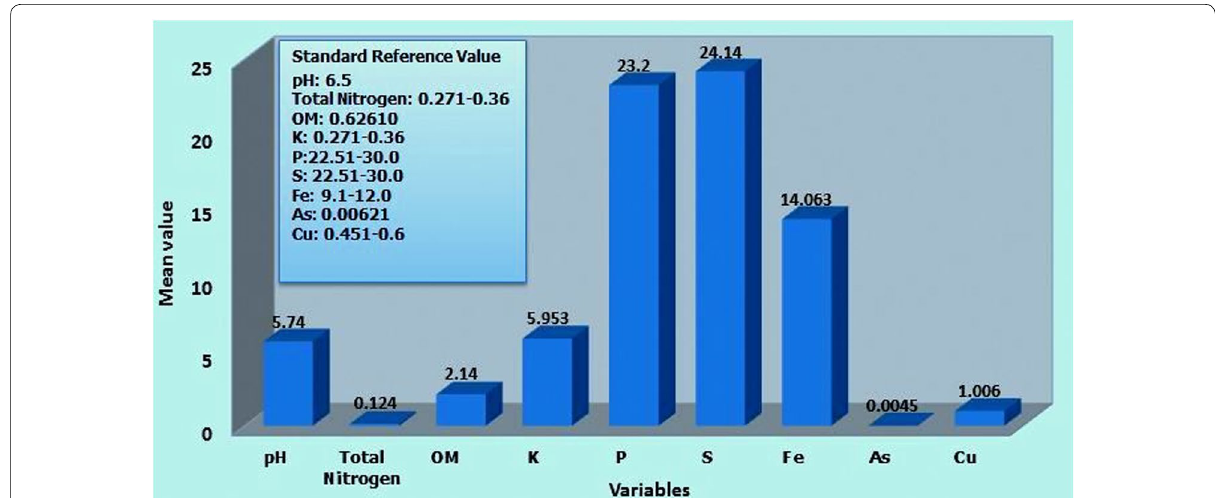
Fig. 3 The mean value of the chemical parameters with their Standard reference